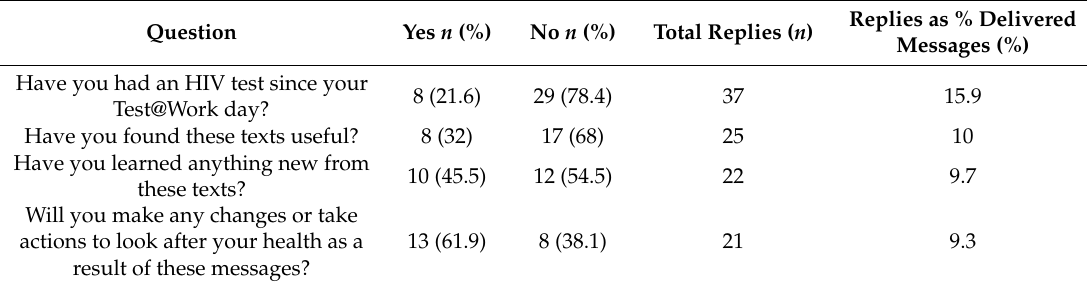
Table 4. Final data collection message